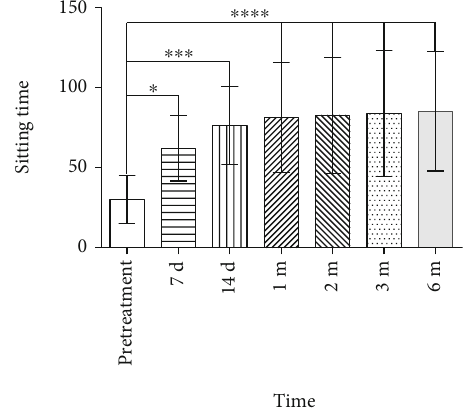
Figure 6: Comparison of sitting time before and after pulsed radiofrequency treatment. The sitting time signi fi cantly increased since day 7 after treatment (pretreatment vs. 7 d, ∗ P < 0 : 05 ; pretreatment vs. 14 d, ∗∗∗ P < 0 : 001 ; and pretreatment vs. 1m, 2m, 3m, or 6m, ∗∗∗∗ P < 0 : 0001 ). There was no signi fi cant di ff erence in the sitting time among 7d, 14 d, 1m, 2 m, 3m, and 6 m after treatment ( P > 0 : 05